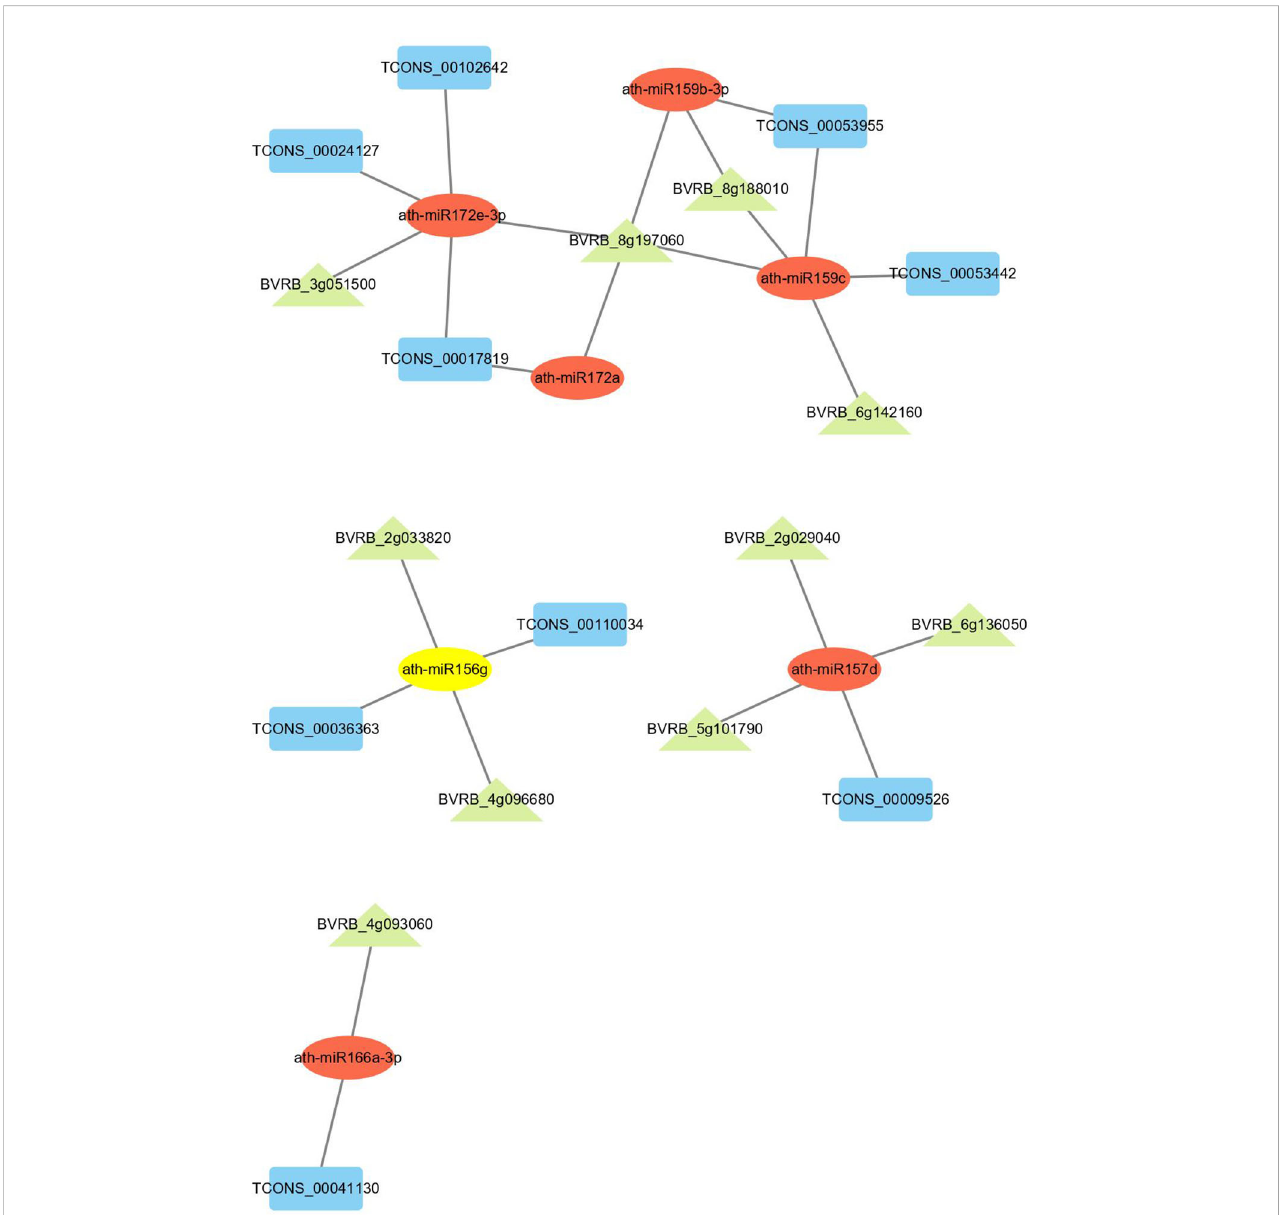
FIGURE 8 CeRNA network in sugar beet under drought stress. Rectangle, ellipse and triangle nodes represent lncRNAs, miRNAs and mRNAs, respectively. The edges represented the competing interactions among